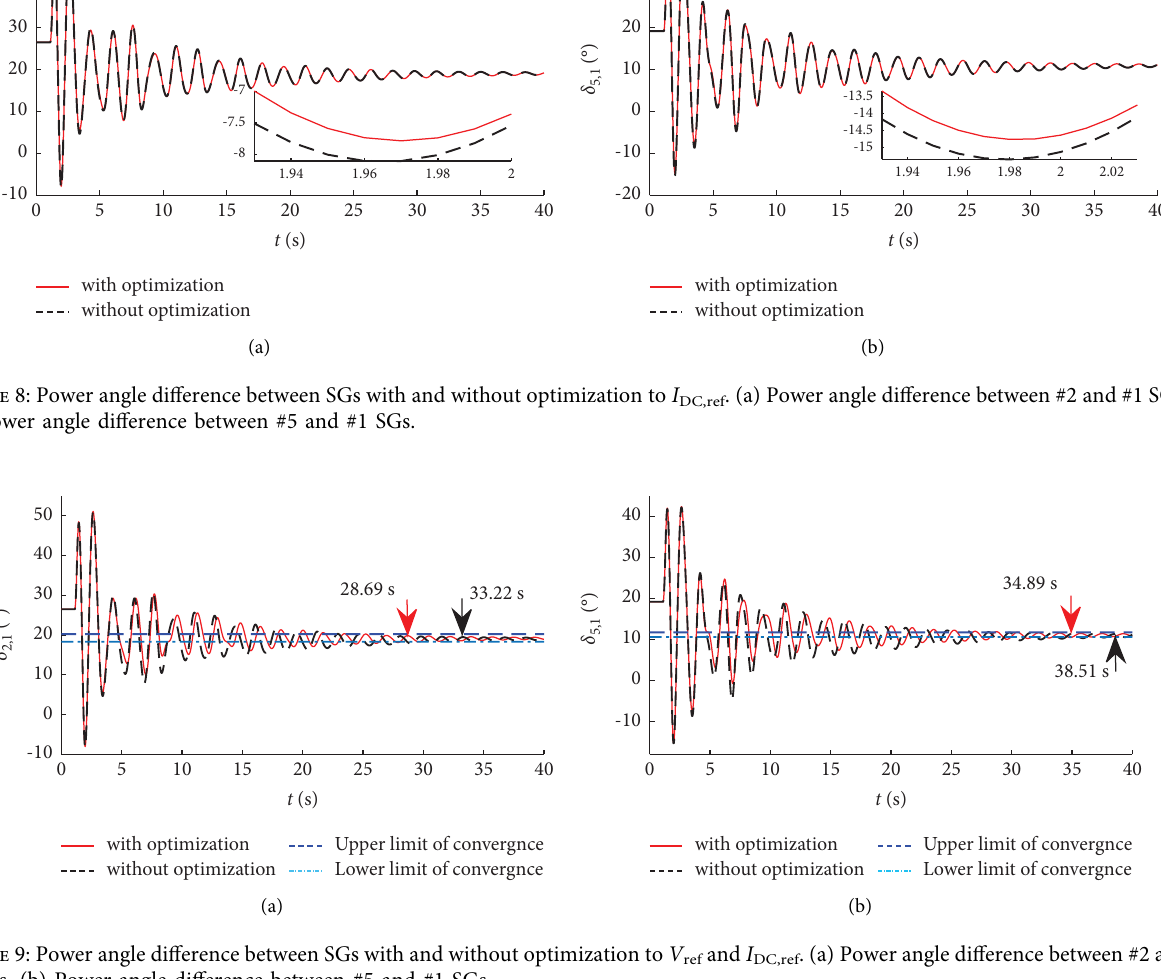
Figure 9: Power angle diference between SGs with and without optimization to V ref and I DC,ref . (a) Power angle diference between #2 and #1 SGs. (b) Power angle diference between #5 and #1 SGs. Table 7: Efect analysis of optimization to V ref and I DC,ref .